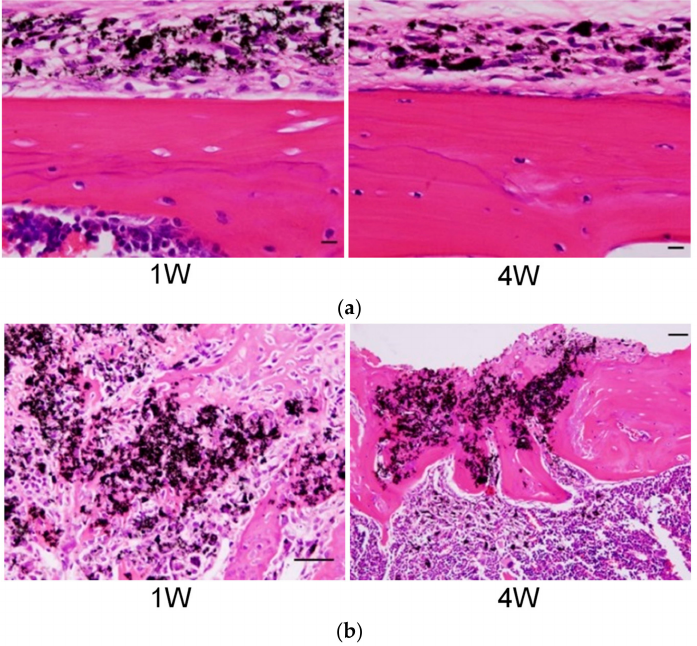
Figure 3. ( a ) Histopathology of ddY mice administered with MWCNTs in the subperiosteum of the skull. MWCNTs were incorporated into macrophages, and no osteolysis was observed in the skull. Scale bar, 20 µ m; ( b ) Histopathology of ddY mice, in which MWCNTs were administered into a tibial bone tunnel. One week after administration, woven bone is formed around MWCNTs, and after 4 weeks, bony cortex is regenerated with MWCNTs incorporated into the bone matrix. Scale bar, 20 µ m. Reproduced with permission from [41]. John Wiley and Sons,